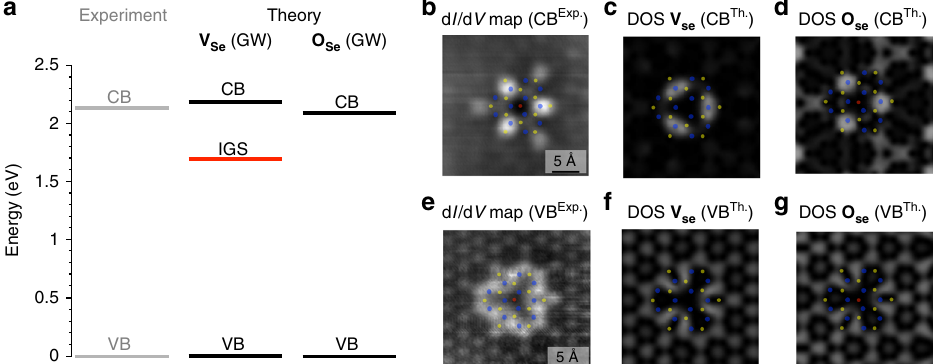
Fig. 4 Comparison of the band energy diagrams and the local density of states of pristine and O substitution Se defects in 2D-MoSe 2 . a Band extrema energies extracted from the experimental dI/dV spectra in Fig. 2a (Experiment, gray) are compared to the corresponding energies (Theory, black) calculated using the GW approximation for the bare Se vacancy − V Se (GW)- and a substitutional O at a Se site − O Se (GW)-. Energies of valence (VB) and conduction (CB) bands are indicated by black lines; the deep in-gap states (IGS) appearing in the V Se are indicated by the red line, which dictates the Fermi level of the calculated system. To aid comparison, all VB energies have been set to zero. The three-fold symmetry and spatial extent observed in the experimental d I /d V constant-height conductance map measured at the b CB energy ( V sample = 0.7 V) are seen on both c the pristine V Se and d the O Se . Similarly, the experimental spatial extent at the e VB ( V sample = − 1.5 V) also reproduced the simulated LDOS of both f V Se and g O